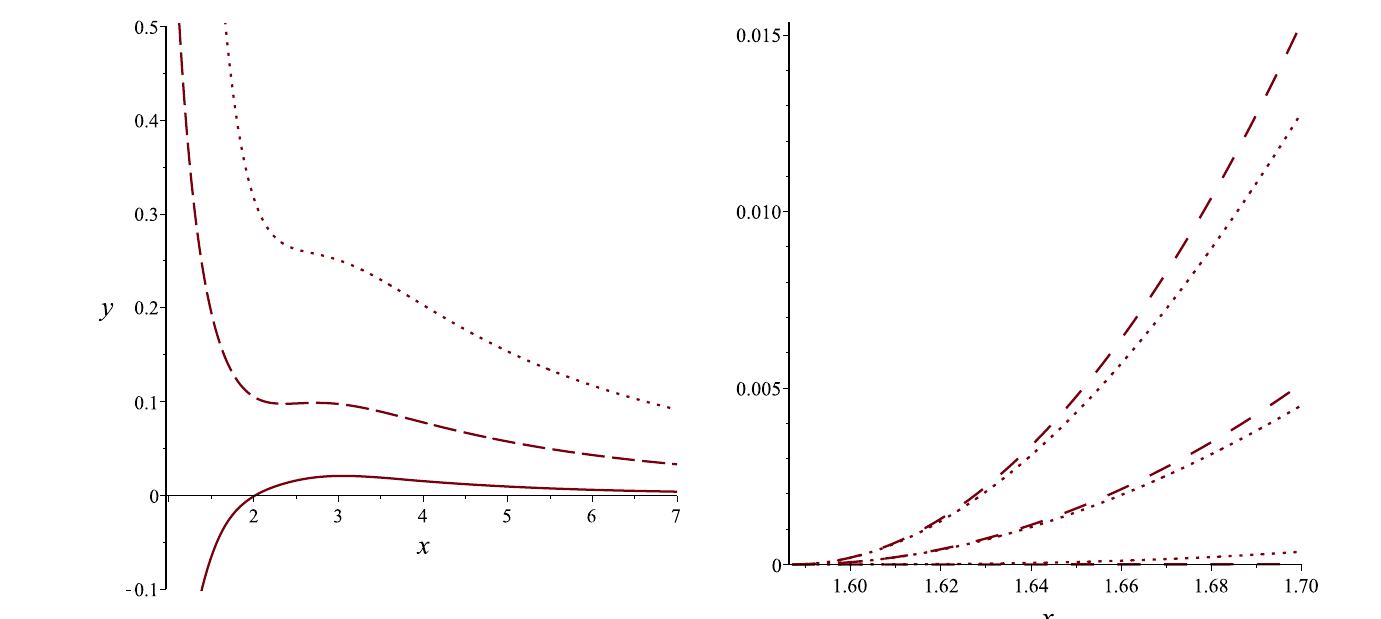
Fig. 3 Plot of the effective potential U ef f in the case of a naked de Sitter core with μ = 1 . 5 and different values of the angular momentum ( (cid:3) = 0 line, (cid:3) = 1 dash, (cid:3) = 2 dot). The label on the y-axis refers to